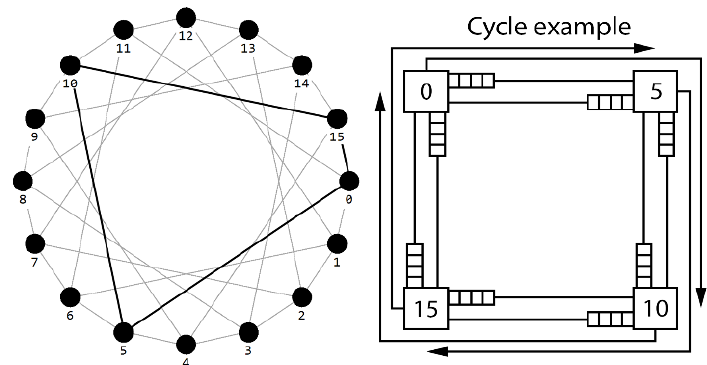
Figure 1. Circulant topology C ( 16; 1, 5 ) . 0 − 5 − 10 − 15 − 0, 0 − 5 − 6 − 11 − 0, etc.—cycles in the topology.